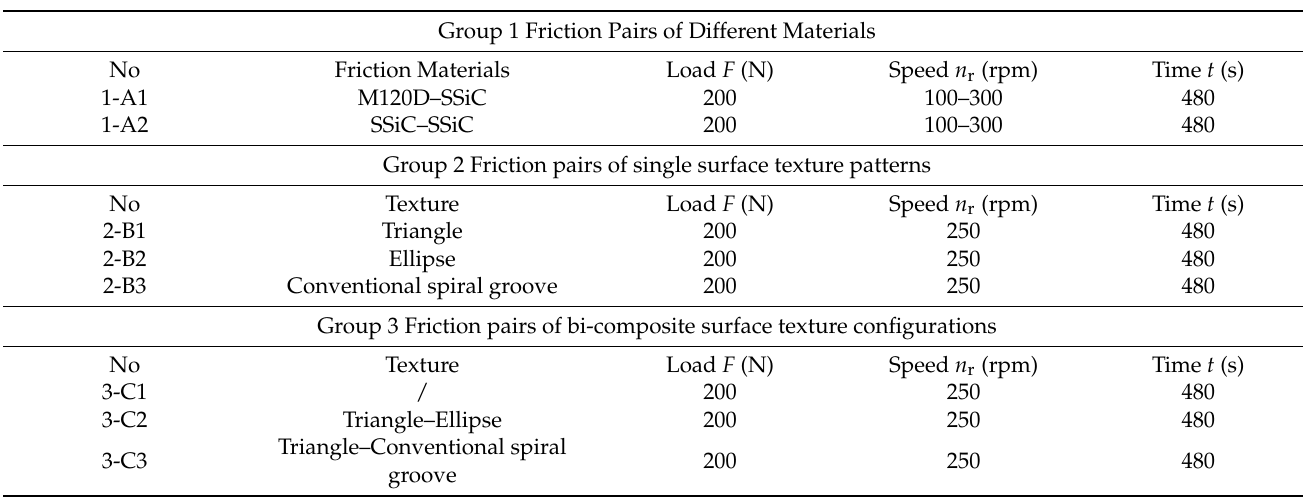
Table 4. Test grouping